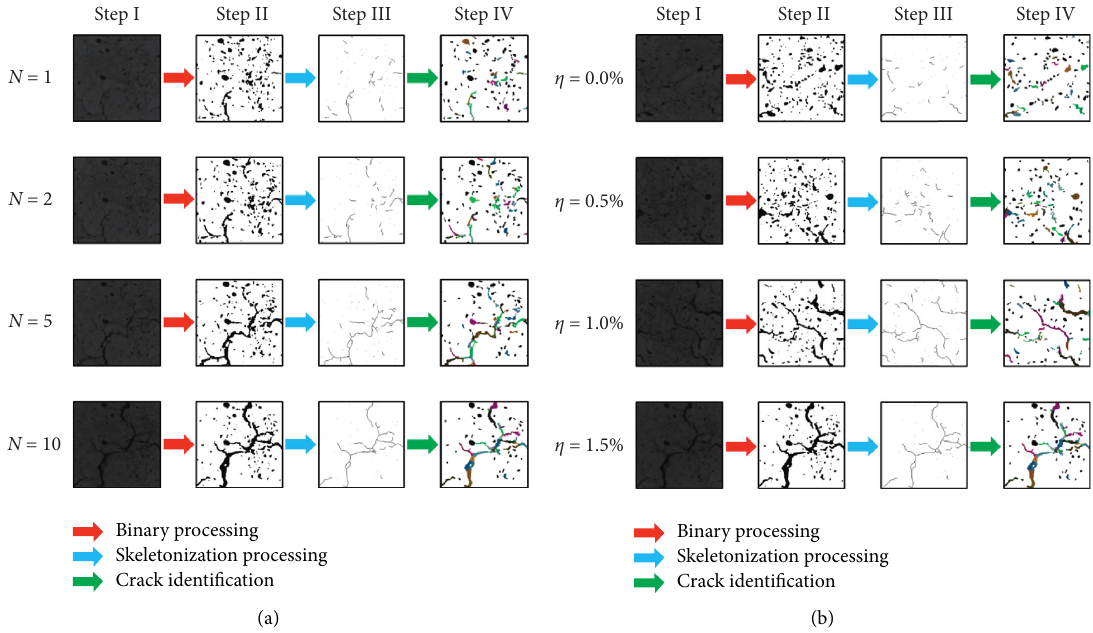
Figure 16: Identification of cracks in the soil. (a) After dry-wet cycles. (b) At various salt